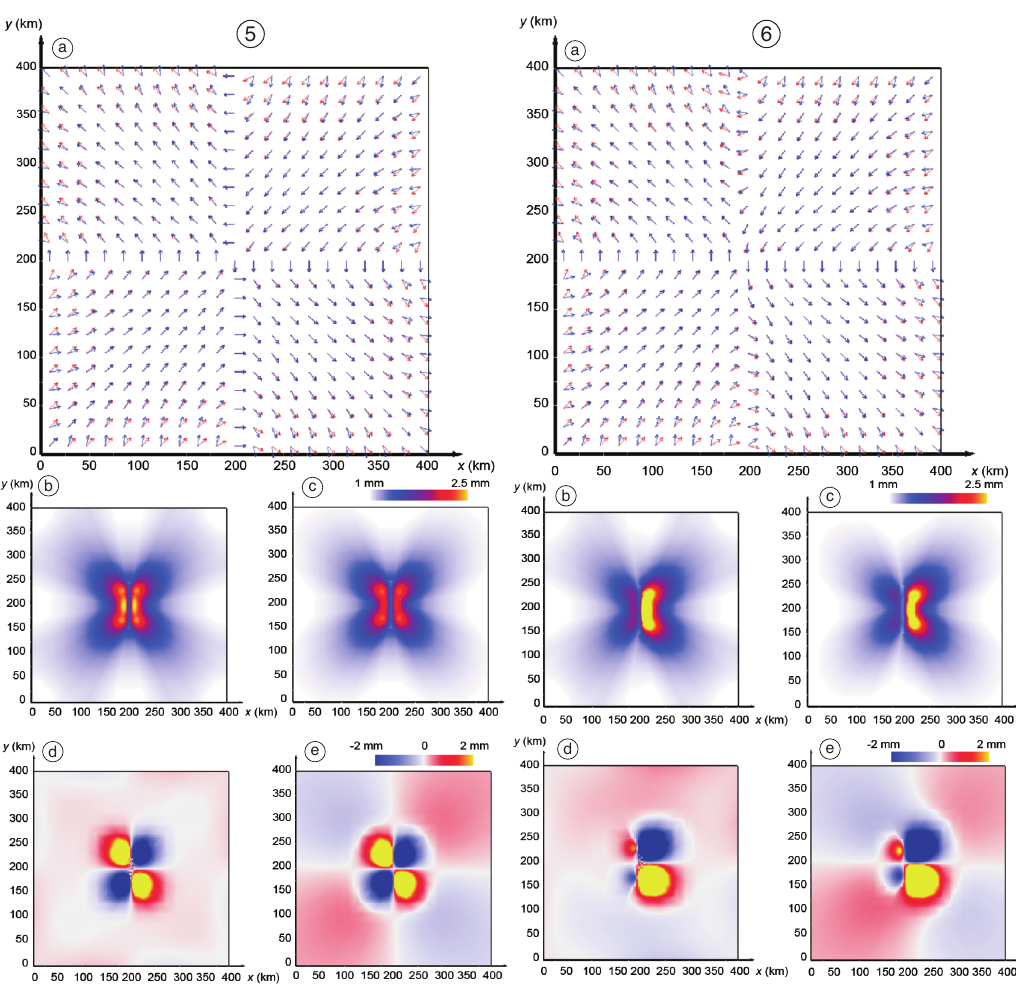
Fig. 5a-e. Same as fig. 3a-e but for a right-lateral strike slip with δ = 90° and φ = 0° when the bottom and lat- eral nodes are fixed in the direction perpendicular to the surface.